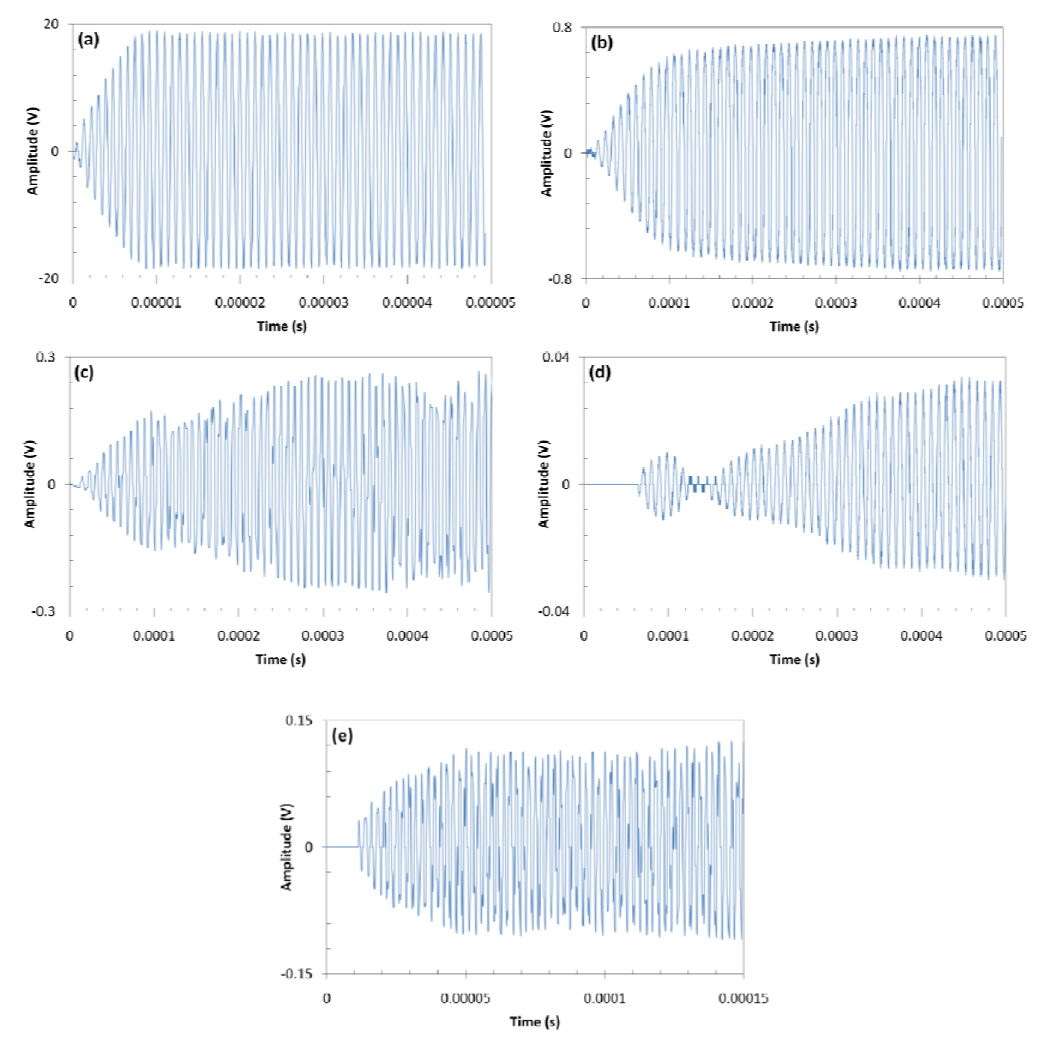
Figure 8. Transient response of the acoustic communications channels, (a)